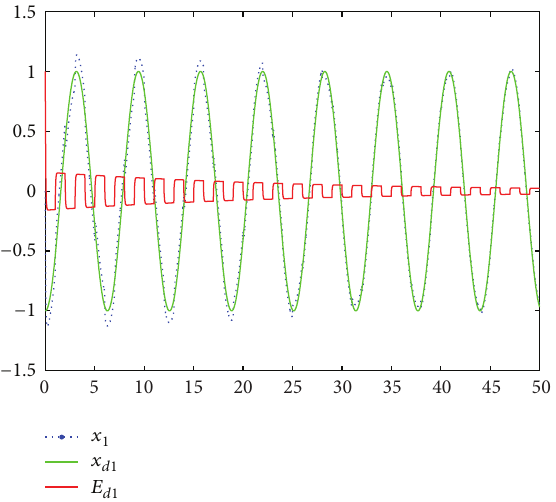
Figure 9: Trajectory tracking result for system state 𝑥 1 .